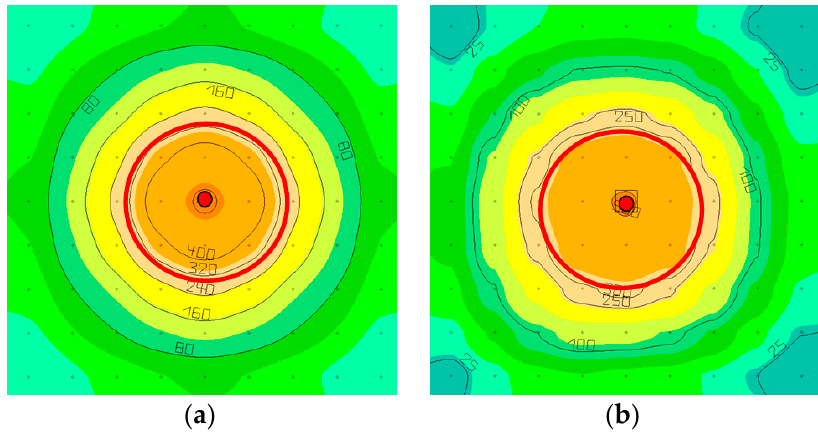
Energies 2019 , 12 , x FOR PEER REVIEW 17 of 21